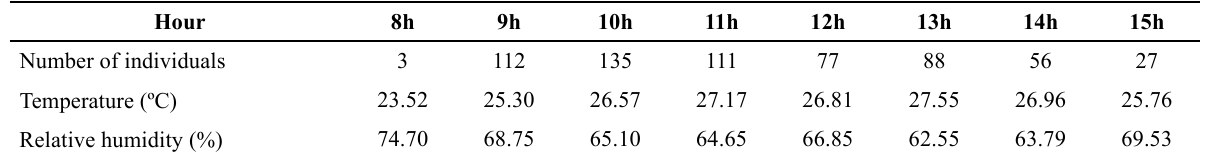
Fig 3 . Shannon-Wienner (H’), Simpson (1-D) and evenness (J) diversity over the months. Table 2 . Number of sampled individuals (grouped data from samplings, without trap plates), average temperature and humidity per time of day, in Ilha Grande, São Francisco do Sul, SC.